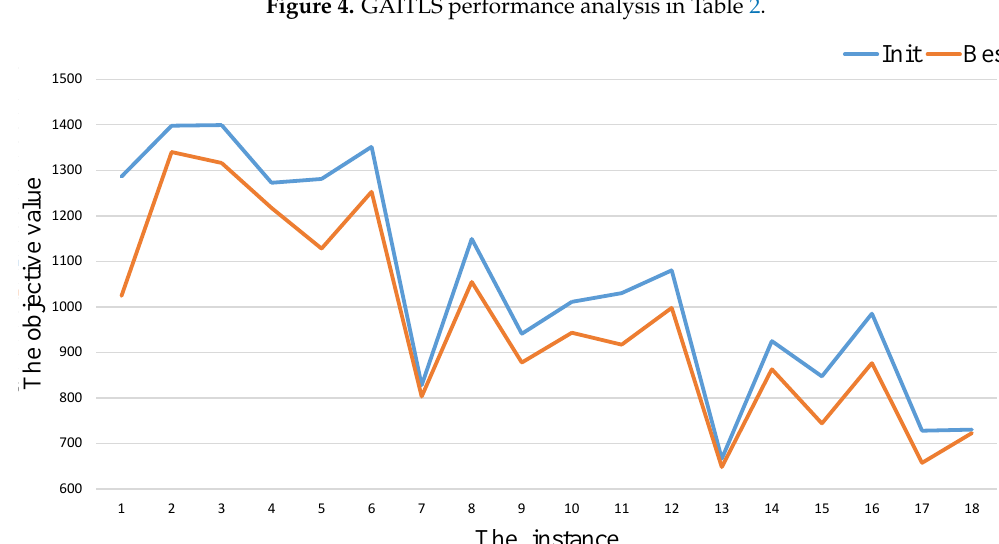
Figure 5. GAITLS performance analysis in Table